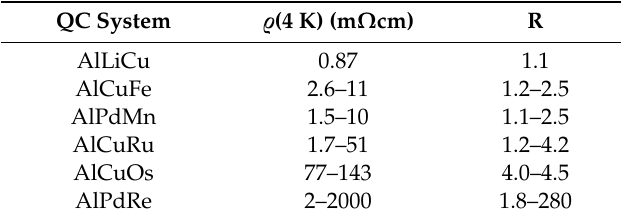
Table 4. Chemical trends in the low-temperature electrical resistivity ( (cid:37) ) and the electrical resistivity ratio (R) defined as R = (cid:37) (4 K) / (cid:37) (300 K) of Al-based i-QCs [57,69–75].